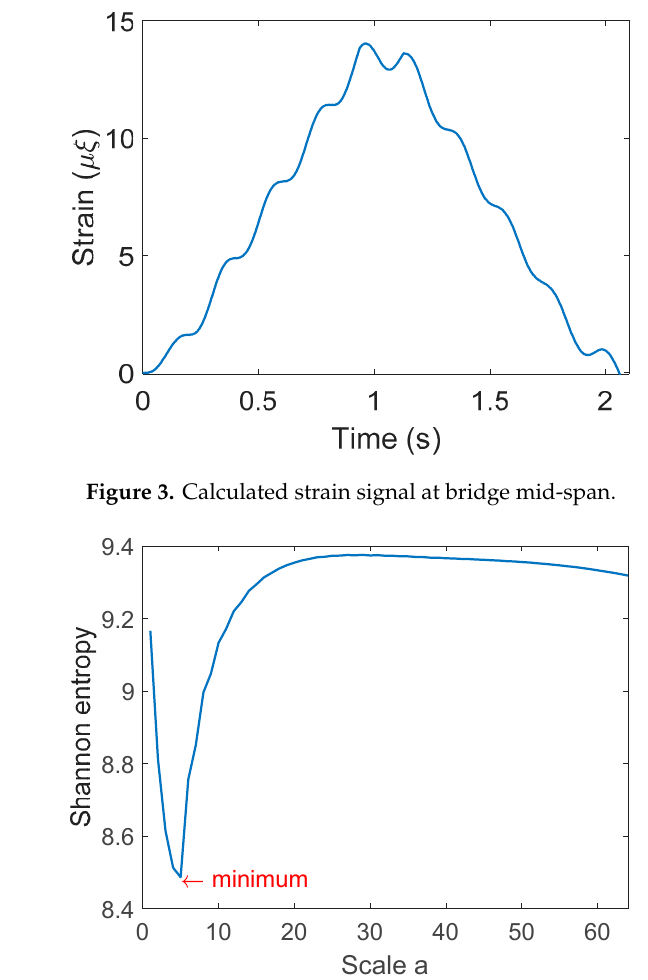
5 of 18 Figure 2. Bridge and vehicle model. Table 1. Properties of vehicle and bridge models. Vehicle Properties